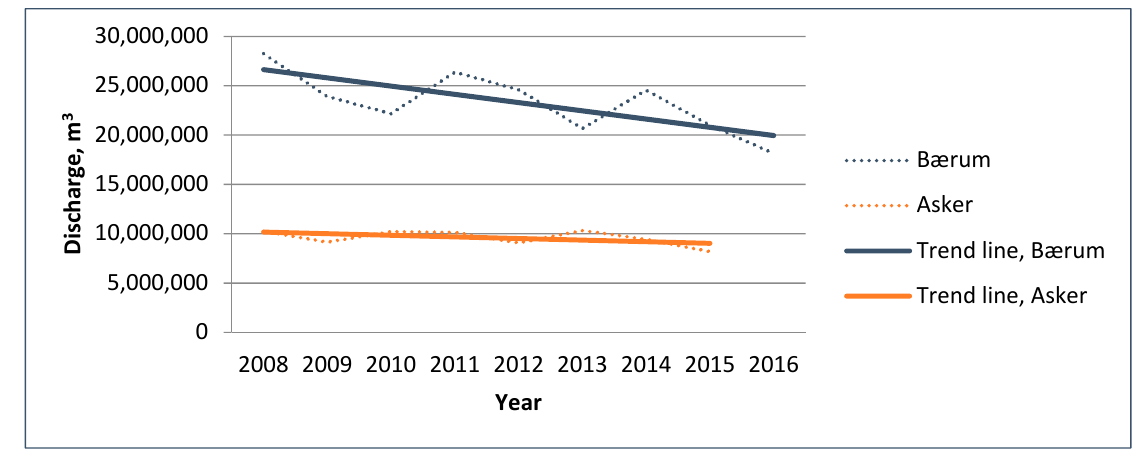
Figure 3. Development of I/I-water in the Asker and Bærum municipalities for 2003–2008.